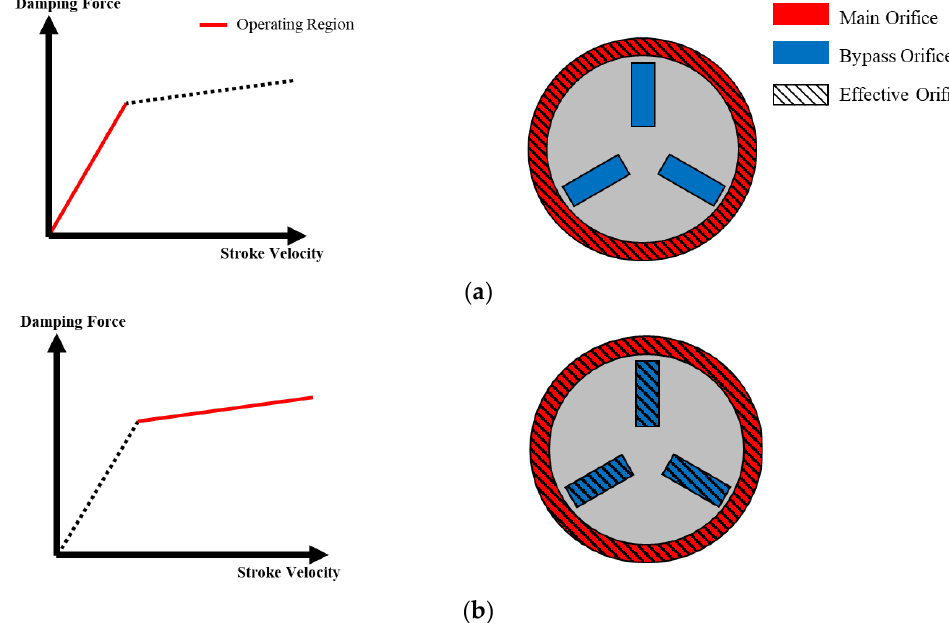
Figure 6. Effective orifice area depending on the operating region: ( a ) the low stroke velocity and high damping coefficient and ( b ) the high stroke velocity and low damping coefficient.